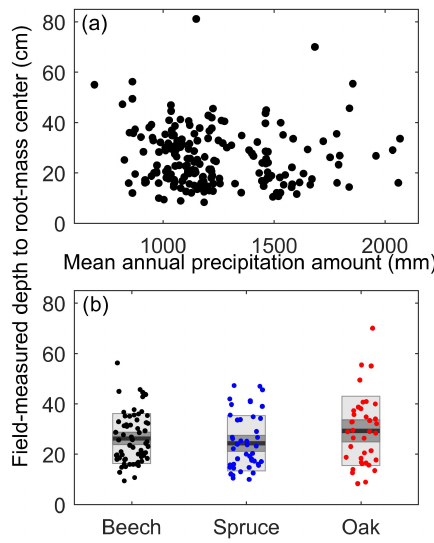
Figure 3. Distributions of the seasonal origin of water in soils and trees across Switzerland in midsummer. Beech and oak xylem show a predominance of winter precipitation. Soil porewaters (sampled by suction lysimeters) and spruce xylem indicate mixtures of pre- cipitation from multiple seasons. Seasonal origin index values be- low 1 reflect waters that are more isotopically negative than typical winter precipitation (estimated by sinusoidal fitting of precipitation patterns; see Sect. 2).